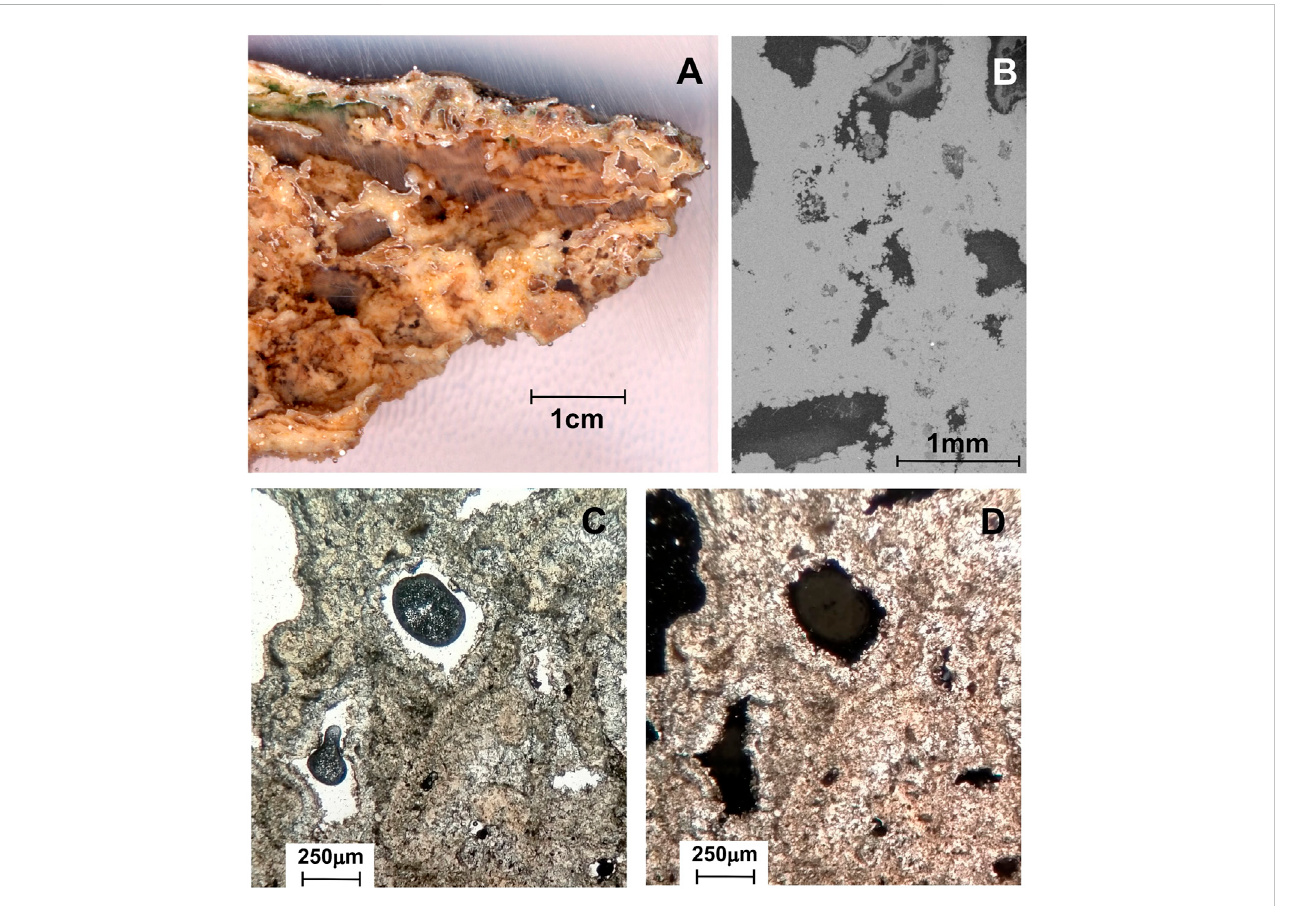
FIGURE 8 Fine-grained lithoclast travertine. (A) Hand specimen photo (B) SEM image showing high porosity and small carbonate crystals (C and D) Microscopic view plane polarized light and crossed nicols respectively. In both, sparry cement lining lithoclasts is